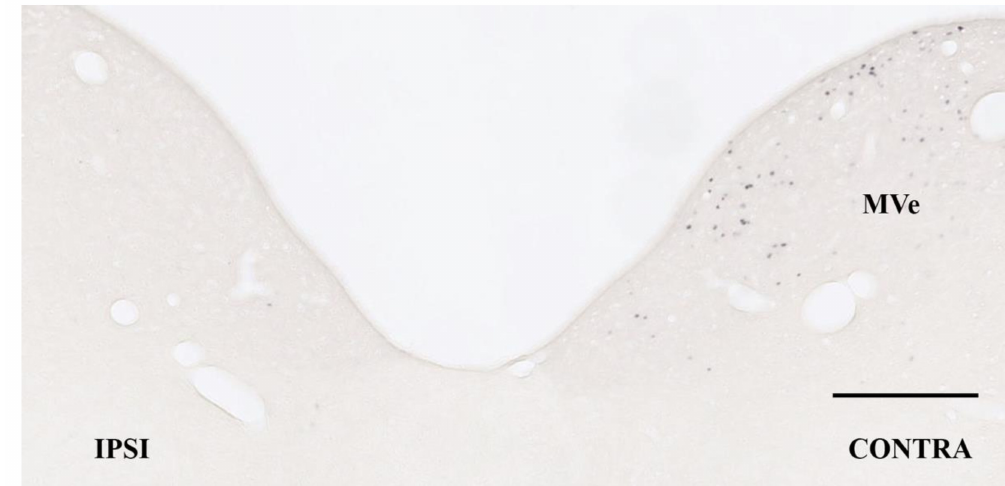
(Figure 3), and equaled the number in the sham-operated rats on day 12 after UL. The number of MK801-induced Fos-positive neurons in the 200 mg/kg/day betahistine-treated rats was also significantly lower than that in the saline-treated UL rats on days 7, 10, and 12, but equaled the number in the sham-operated rats on day 10 after UL. Moreover, the number of MK801-induced Fos-positive neurons on day 10 after UL was significantly lower in the rats that received 200 mg/kg/day betahistine than in those that received a 100 mg/kg/day dose (Figure 3).